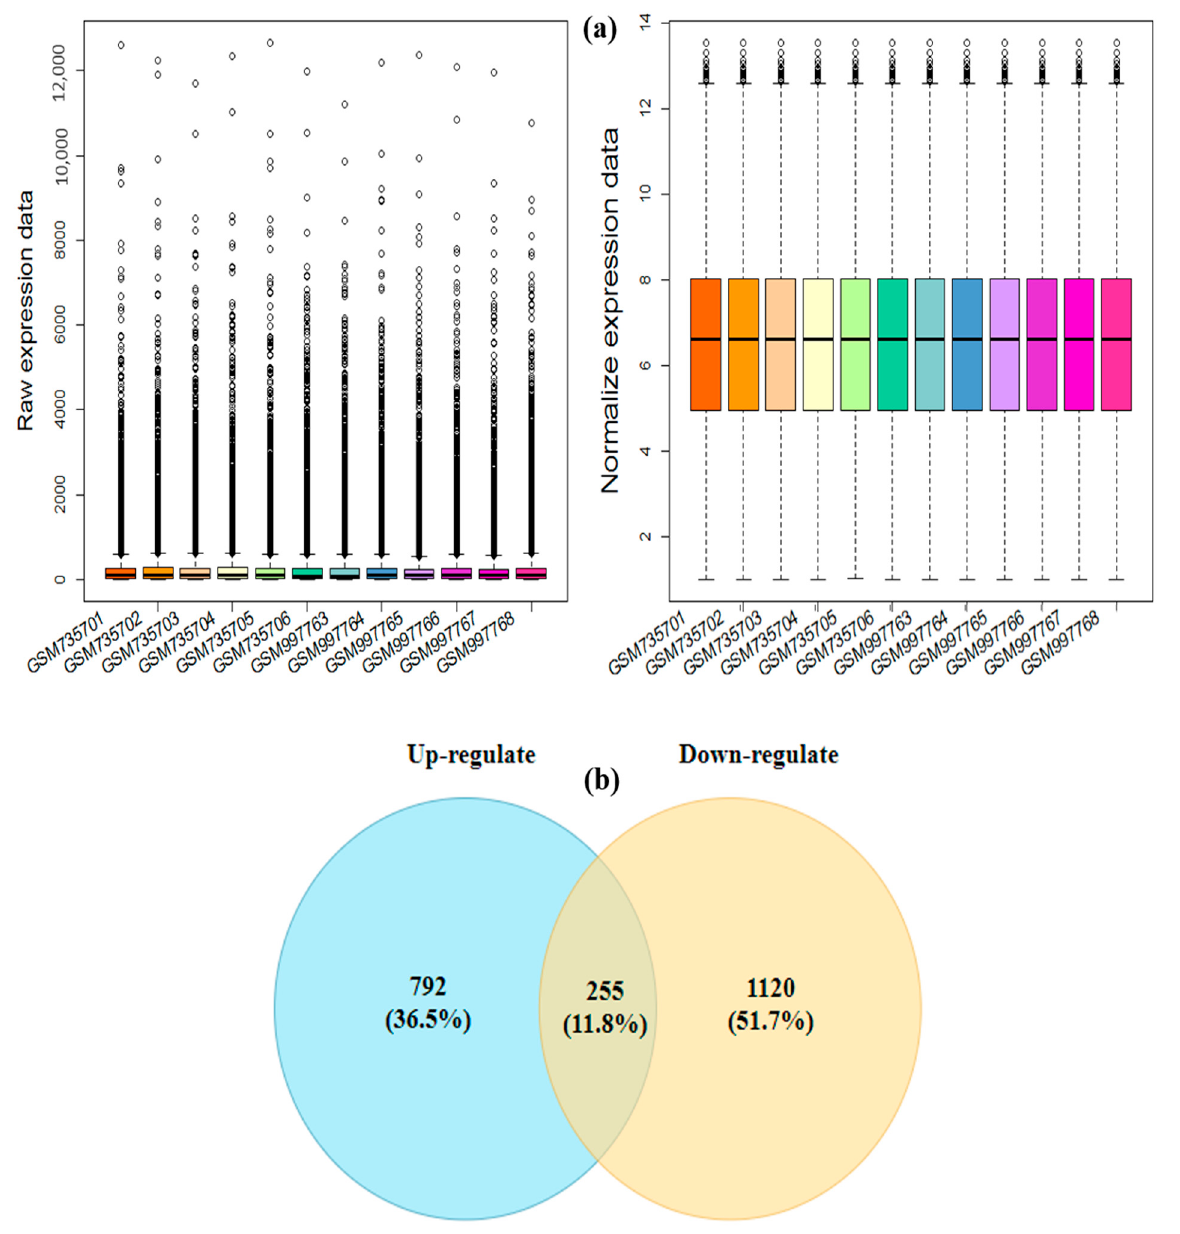
Figure 2. ( a ) Pre-processing of microarray studies. The E-GEOD-40627 study boxplot related to drought stresses in the Affymetrix platform, with 6 control samples and 6 treatment samples, was drawn for the pre- and post-normalization stages. The boxplot is presented after normalization, where all comparisons that are not significant or are not equal to the change threshold are converted to a log 2 value to remove possible errors. The black lines of the boxplot are almost on the same straight line, indicating a high level of normalization. The horizontal axis stands represents the control and different treatment samples, while the vertical axis represents the expression values. The black line in the box represents the median expression for each sample. ( b ) Venn diagrams illustrating the numbers of down- and upregulated DEGs in the drought stress studies. The intersection in grey represents the DEGs common between the two